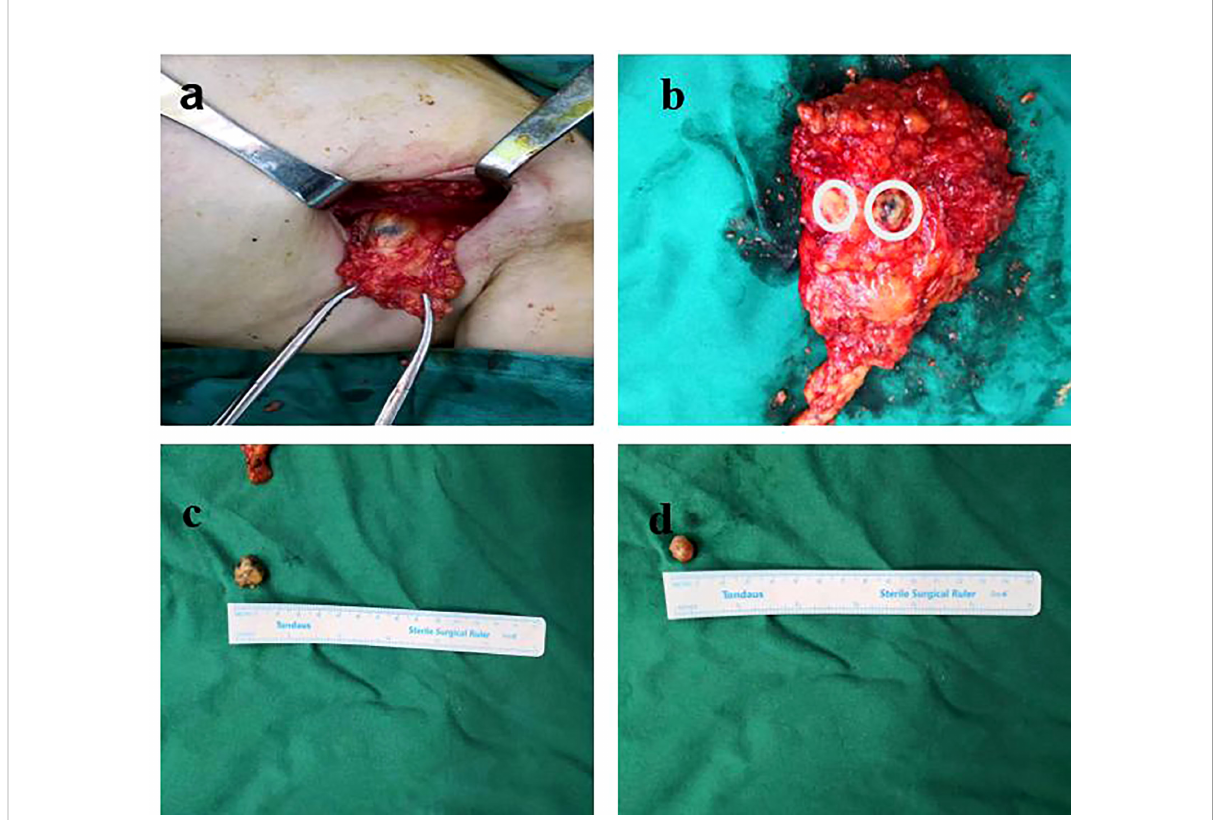
FIGURE 2 Lymph nodes were resected according to the order of the preoperative labeling on DLCT images. (A) Labeled lymph nodes of each participant were evaluated by the same breast surgeon who had conducted the surgical resection of those labeled lymph nodes. (B) The intact axillary tissue and related lymph nodes were carefully retained. (C, D) The removed lymph nodes were measured and numbered, and communication was maintained with the